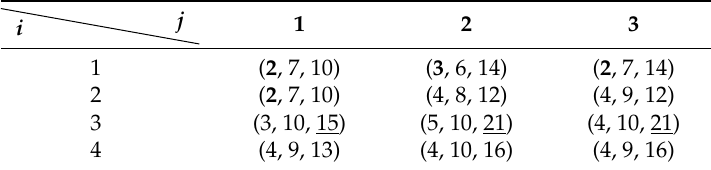
Table 4. Triangular fuzzy values ξ i , j = ( α i , j , β i , j , χ i , j ) in Figure 2.